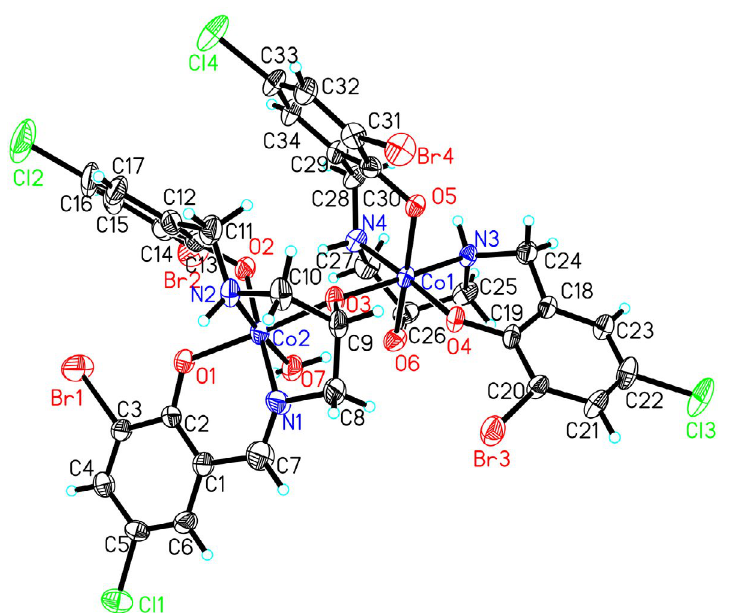
Fig. 3. The dinuclear complex moiety of 2 . The two water molecules are omitted for clarity. Displacement ellipsoids are drawn at the 30% probabili- ty level and H atoms are shown as small spheres of arbitrary radii.